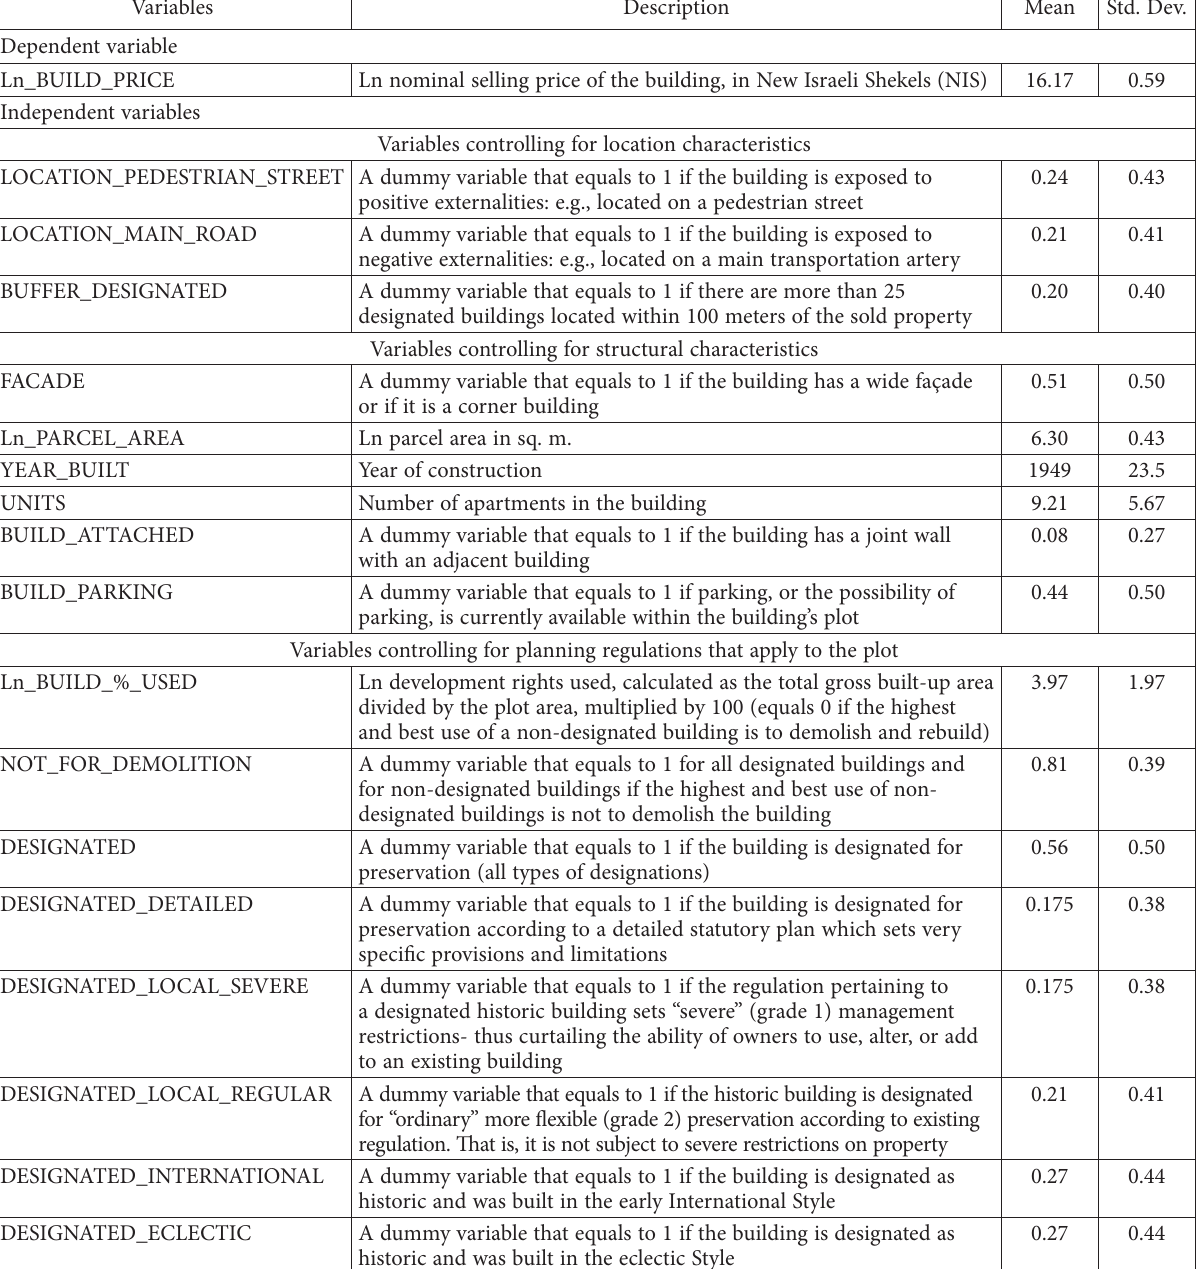
Table 1. Main variables included in the hedonic price method – building